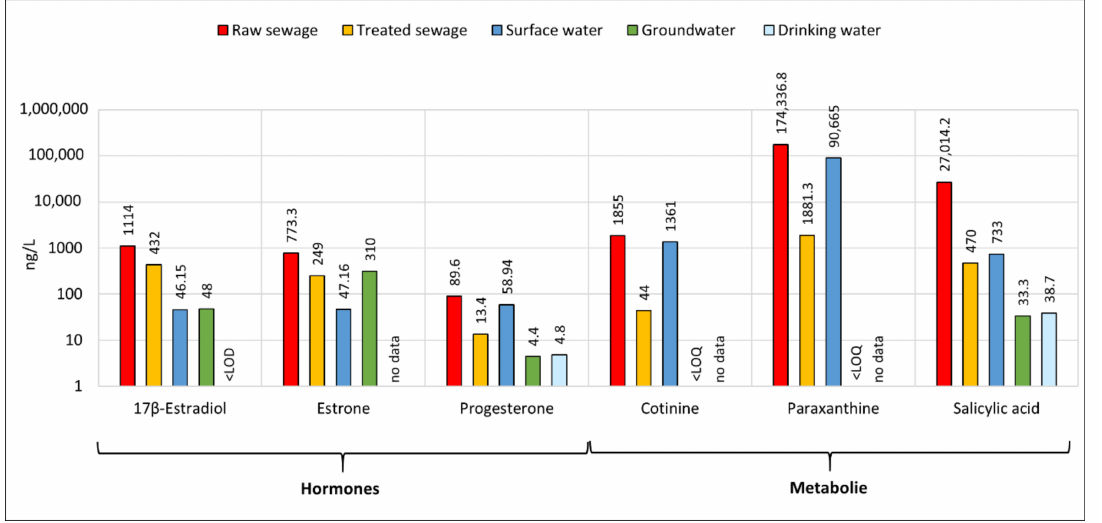
Figure 7. Variations in maximum concentrations of selected hormones and metabolites in different water sample